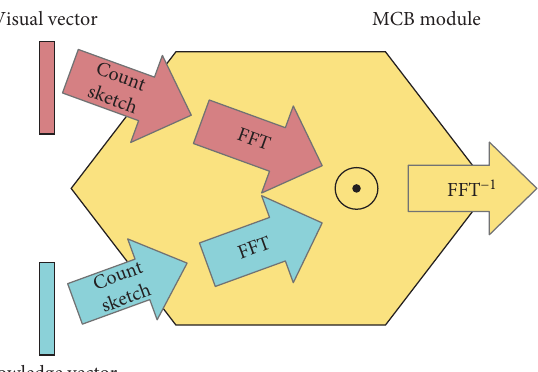
Figure 3: The structure of MCB module. The input of MCB module consists of the visual vector and knowledge vector. After using the Count Sketch projection function to reduce the dimension of them, the two kinds of vectors are fused in the Fourier space and finally output the high-order